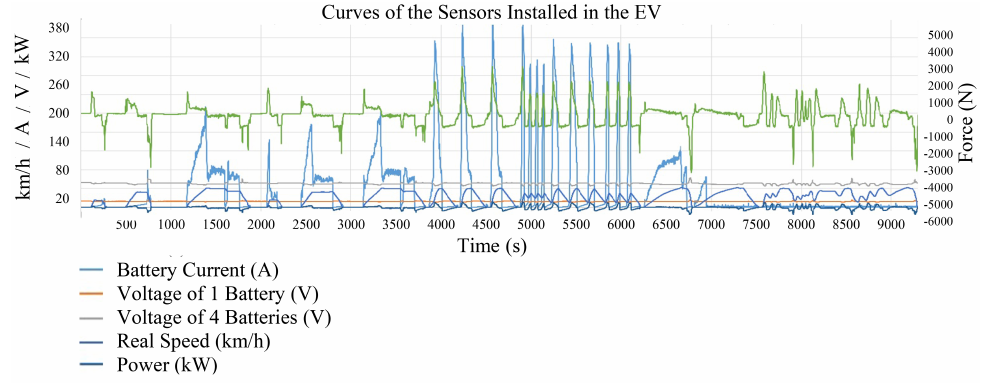
Figure 2. EV prototype test bench ( a ) under test on a roll bench ( b ) different sensors connected to the EV ( c ) on a dynamometer for the different measurements